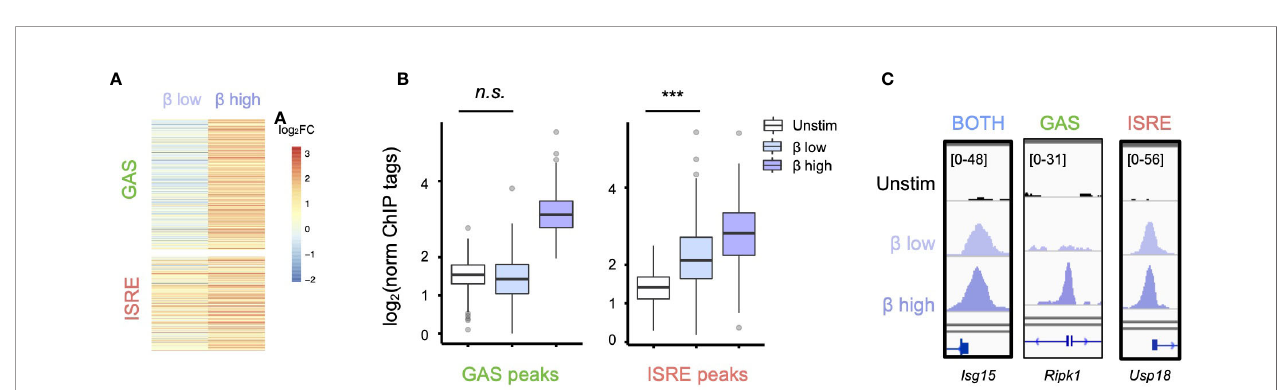
FIGURE 2 | Low-dose IFN- b preferentially activates ISGF3 over GAF. (A) Heatmap of STAT1 ChIP-seq with two doses of IFN- b (1vs 10 U/ml) for 1h, showing GAS and ISRE clusters identi fi ed in Figure 1F . (B) Boxplot of STAT1 ChIP-seq signals for GAS cluster peaks in (B) . n.s., not signi fi cant, *** = p < 2.2 e-16 by one-way Wilcox ranked sum test. (C) Genome browser tracks of representative promoter-bound STAT1 ChIP-seq peaks from "Both" ( Isg15I ), GAS (Ripk1) , and ISRE (Usp18) clusters across two doses of IFN- b